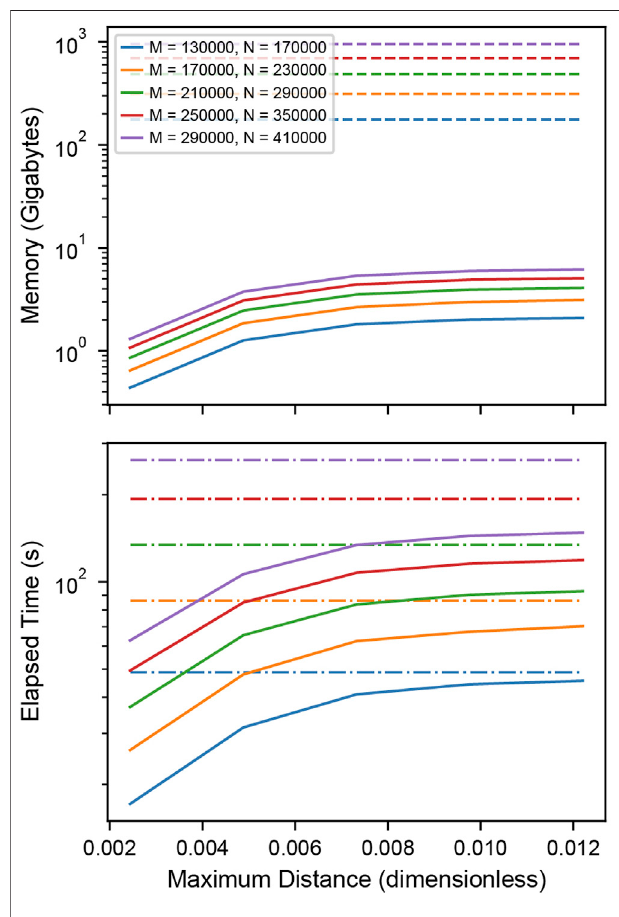
FIGURE3| Performanceofdistancetabulationusingak-dtreeandrange search vs. a full distance matrix. (A) Simulated data sets as in Figure 2 with varying numbers of localizations were analyzed to measure the memory needs for calculating the full distance matrix (dashed) and k-dimensional tree (solid)withdistancecutoff.Formatricesthatcouldnotexplicitlybeallocatedinto memory, a linear extrapolation was applied to estimate the allocation time (dot- dashed).The total numberofclusters isincreased withanincreasing numberof localizations to increase the memory requirements of the distance tabulation. The distance is expressed as a fraction of the fi eld of view. For relevant length scales, the tree usessigni fi cantly lessmemorythanthe matrix. (B) Elapsed time for calculating the full distance matrix (dashed) vs. the k-dimensional tree (solid). Whenarealisticnumberoflocalizationsisincludedinthedistancetabulation,the distance tabulation for the tree takes less time than the full